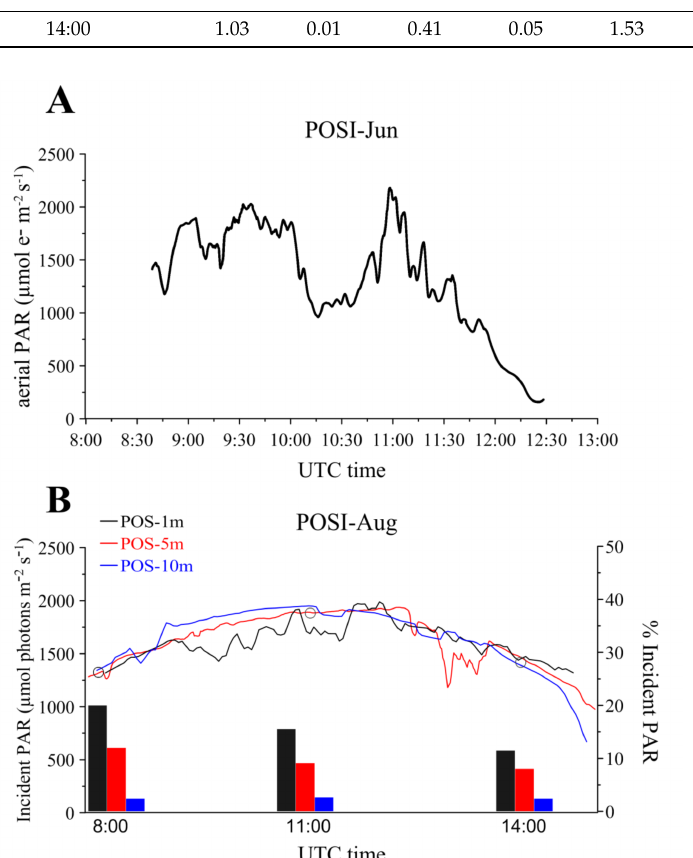
Figure 3. PAR (Photosynthetic Active Radiation, µ mol photons m − 2 s − 1 ) registered at POS-1m (black), POS-5m (red) and POS-10m (blue) during ( A ) POSI-Jun conducted on 7 June 2018 and ( B ) POSI-Aug on 9, 10 and 13 August 2018. Continuous lines represent the incident PAR time series, while histograms represent the percentage of incident PAR measured at canopy